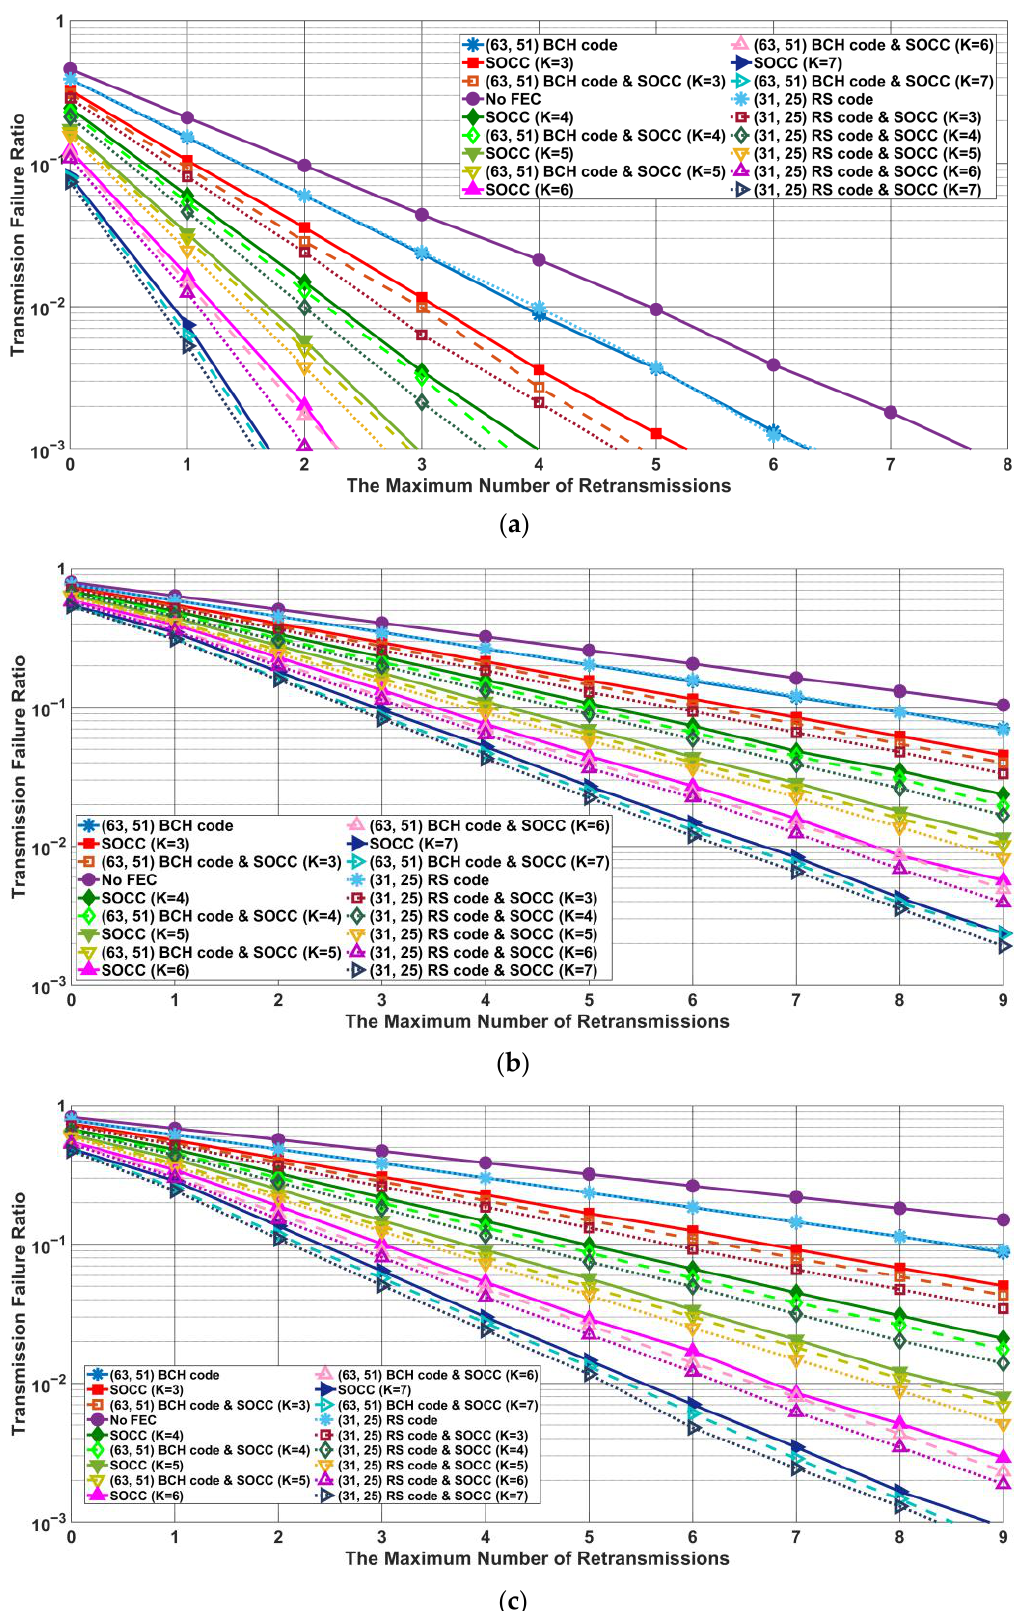
Figure 7. Transmission failure ratio as a function of the maximum number of retransmissions in the case of the single pulse option for each link type: ( a ) LD, ( b ) MD, and ( c ) HD.